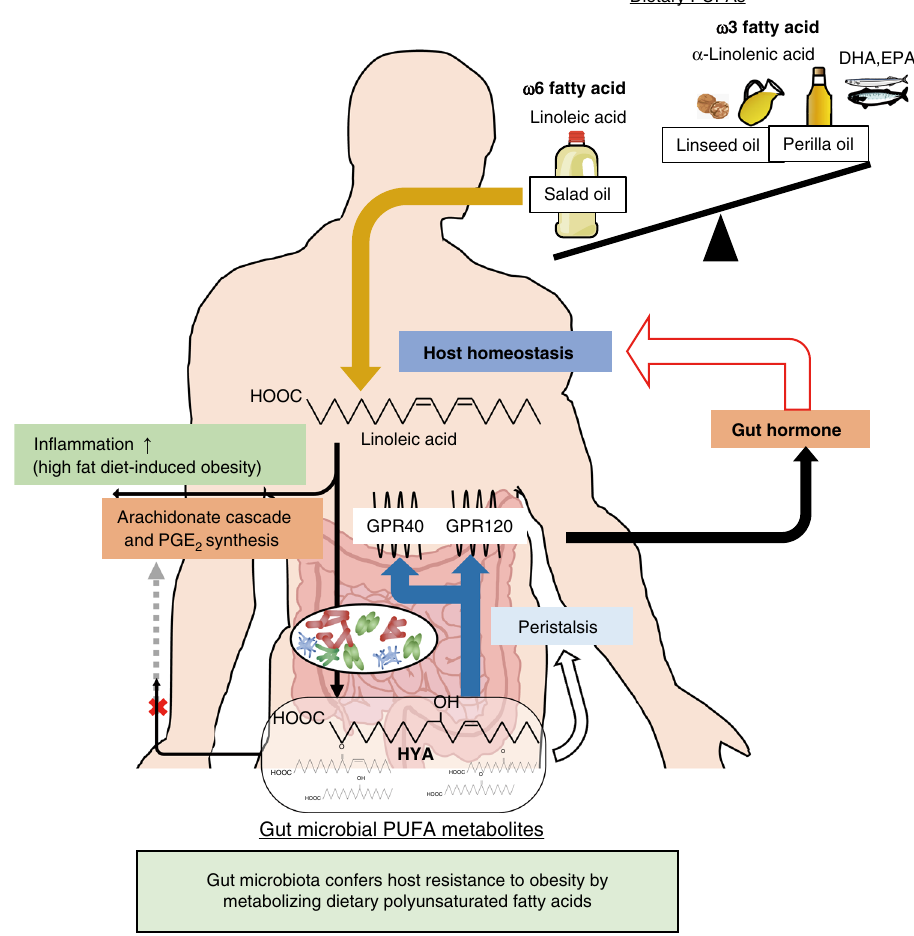
Fig. 8 Schematic representation. The mechanism by which gut microbial metabolism of dietary PUFAs confers host resistance to